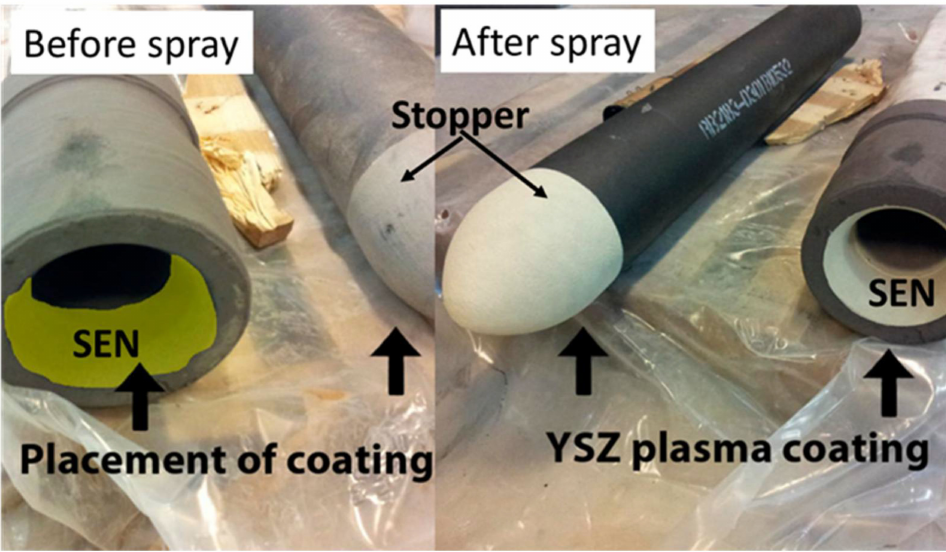
Figure 10. Illustration of a SEN and a stopper rod coated with YSZ by plasma spraying. SEN = sub- merged entry nozzle, YSZ = yttria stabilized zirconia. The approximate diameter of this nozzle is 185 mm. Adapted with permission from [23]. 2018, Taylor &